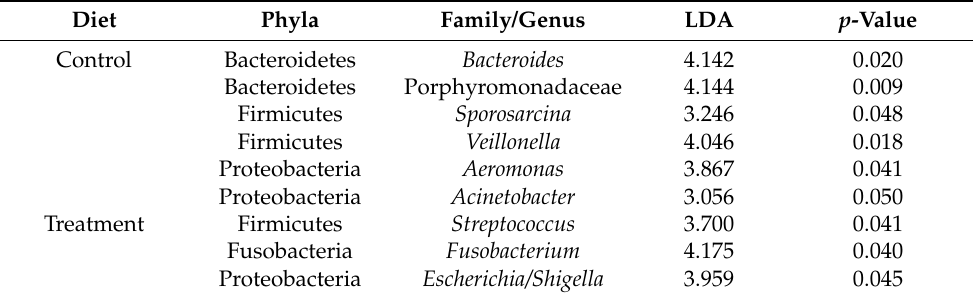
Table 4. Linear discriminant analysis effect size (Lefse) of indicator bacteria species that were significantly ( p < 0.05) associated with each